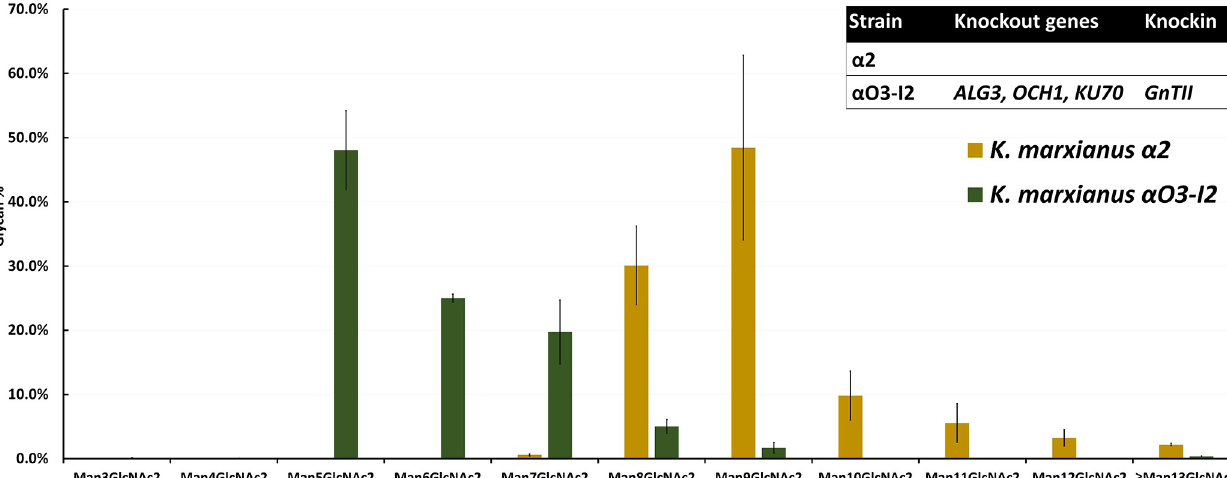
Fig 2. Profiles of N-glycans in K . marxianus α 2 and α O3-I2 strains. The proportion of Man 5 GlcNAc 2 in K . marxianus α O3-I2 (the left dark green color bar) was greatly increased compared to that in K . marxianus α 2. The number of replicates in each experiment is 3 (N =